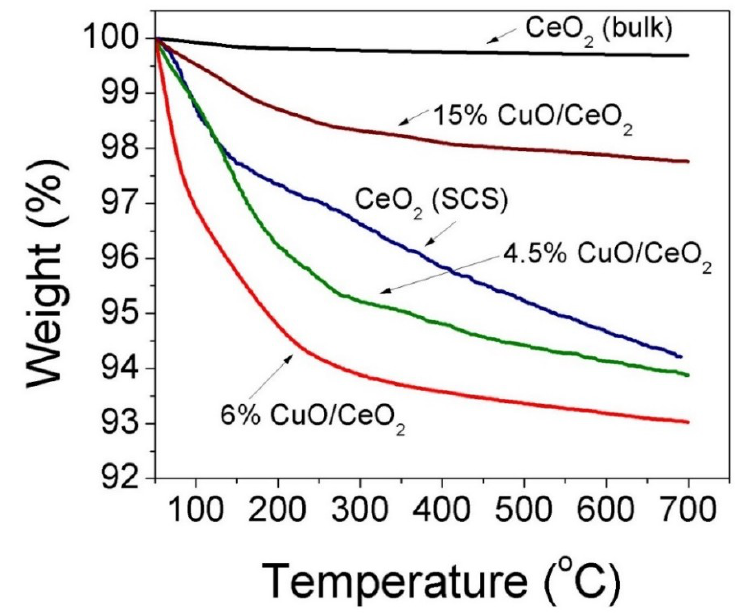
Figure 3. TGA profiles of ( a ) bulk ceria ( b ) CeO 2 , ( c ) 4.5% CuO-CeO 2 , ( d ) 6% CuO-CeO 2 and ( e ) 15% CuO-CeO 2 prepared by solution combustion method.